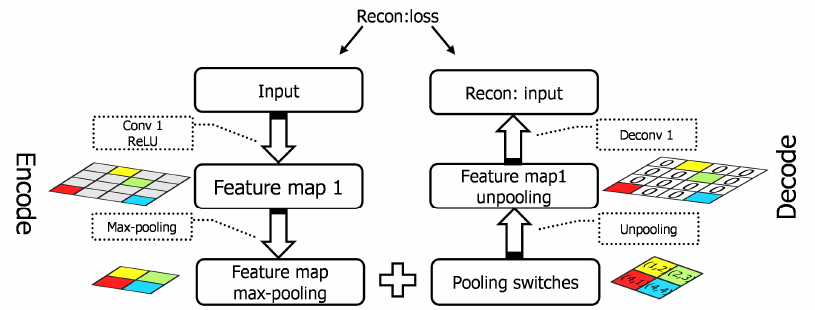
Figure 2. One-layer convolutional